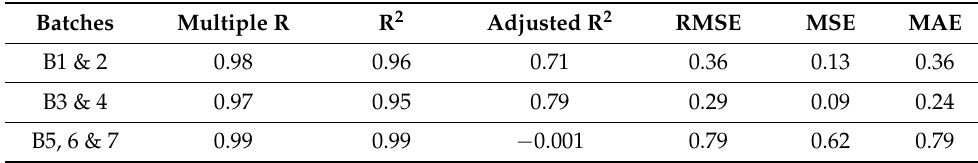
Figure 14. Actual vs. Predicted Concrete Flexural Strength Values with Testing Dataset. Table 10. Flexural Strength Results of ANN